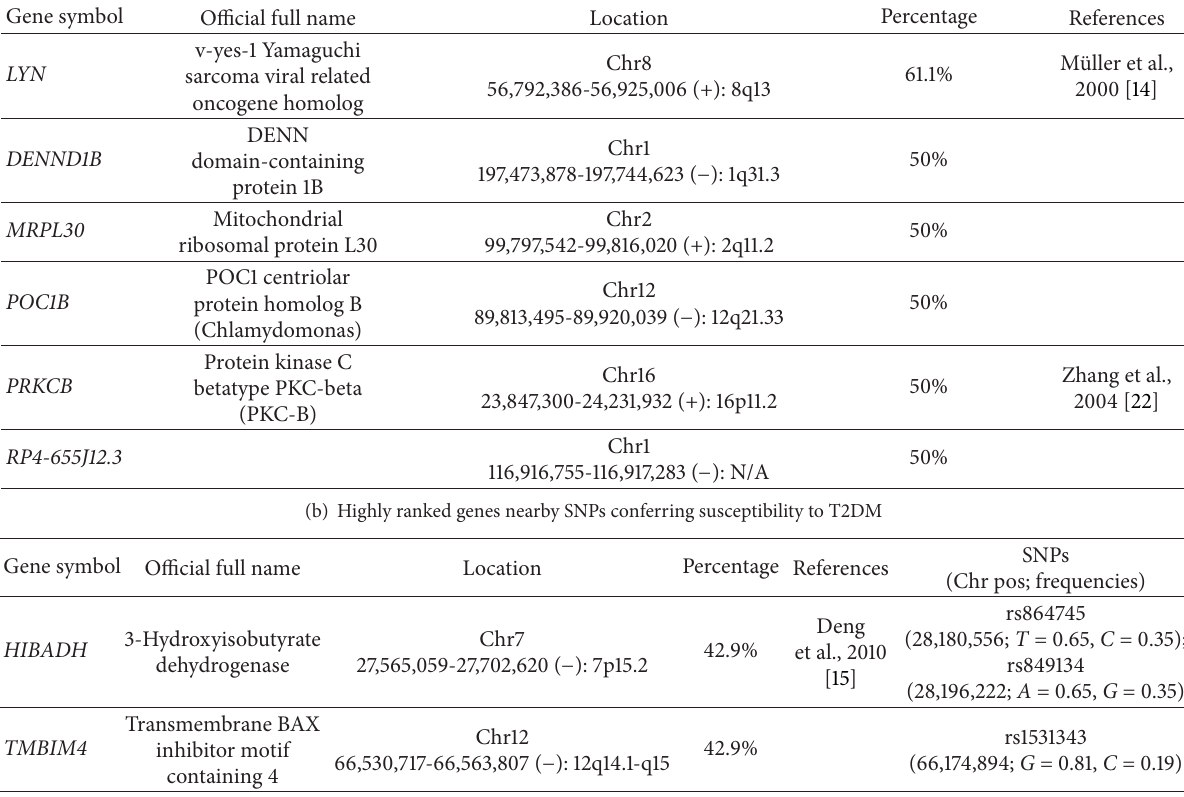
Table 1: Highly ranked genes in T2DM-control study. (a) Highly ranked genes with high percentages in T2DM-control